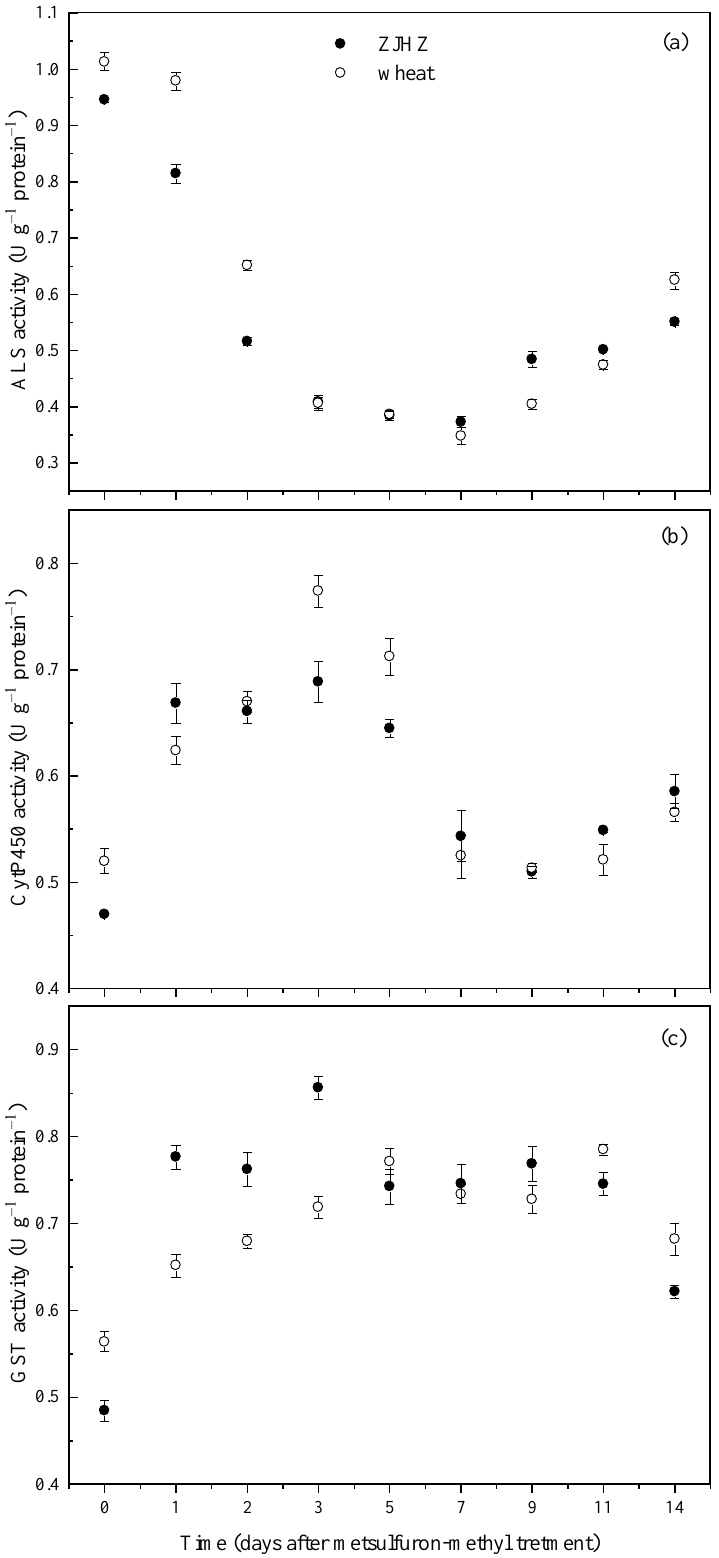
Figure 4. Activities of ALS ( a ), CytP450 ( b ), and GST ( c ) in R. kamoji population ZJHZ and compared with T. aestivum at 0 to 14 days after metsulfuron-methyl treatment. Each point is the mean ± SE of twice-repeated experiments, each containing four